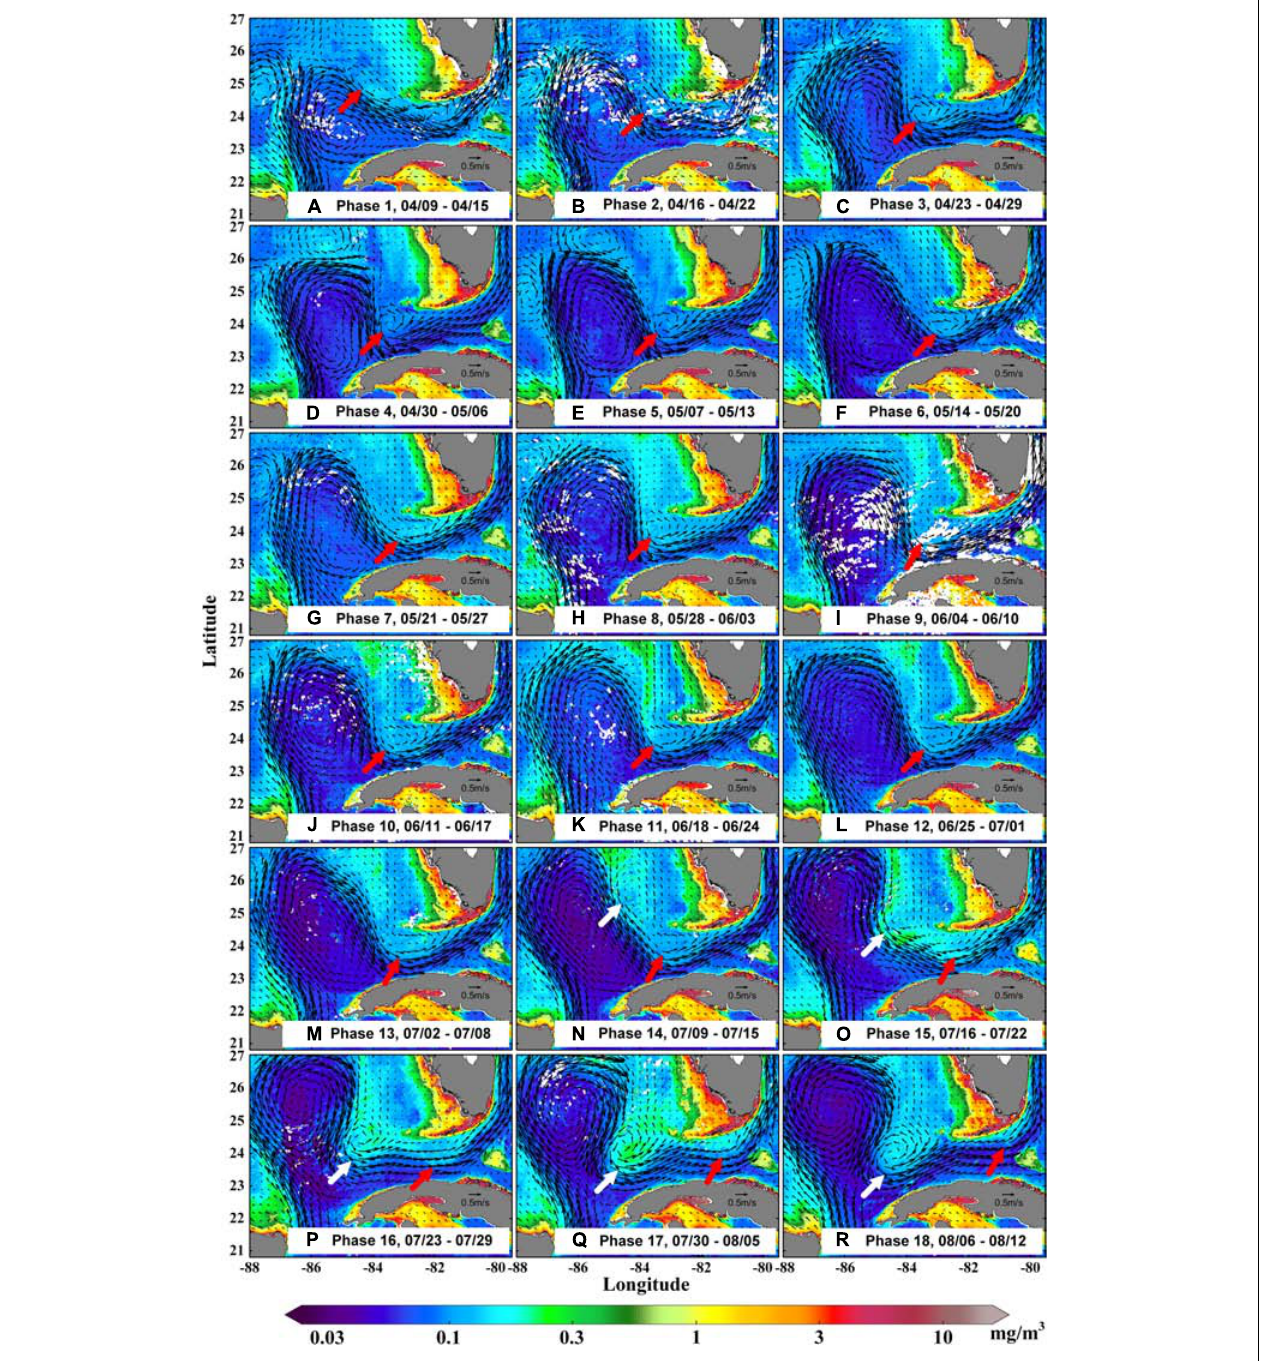
FIGURE 5 | Sequential weekly MODIS/A Chl imagery with weekly global HYCOM simulated surface currents (black vectors, with scales overlaid on land) overlaid from 04/09/2017 to 08/12/2017, showing the entire evolution of a model-simulated CE annotated with a thick red arrow in each image (A–R) . White color means no data, and thick white arrows denote a new LC frontal eddy in (N–R)